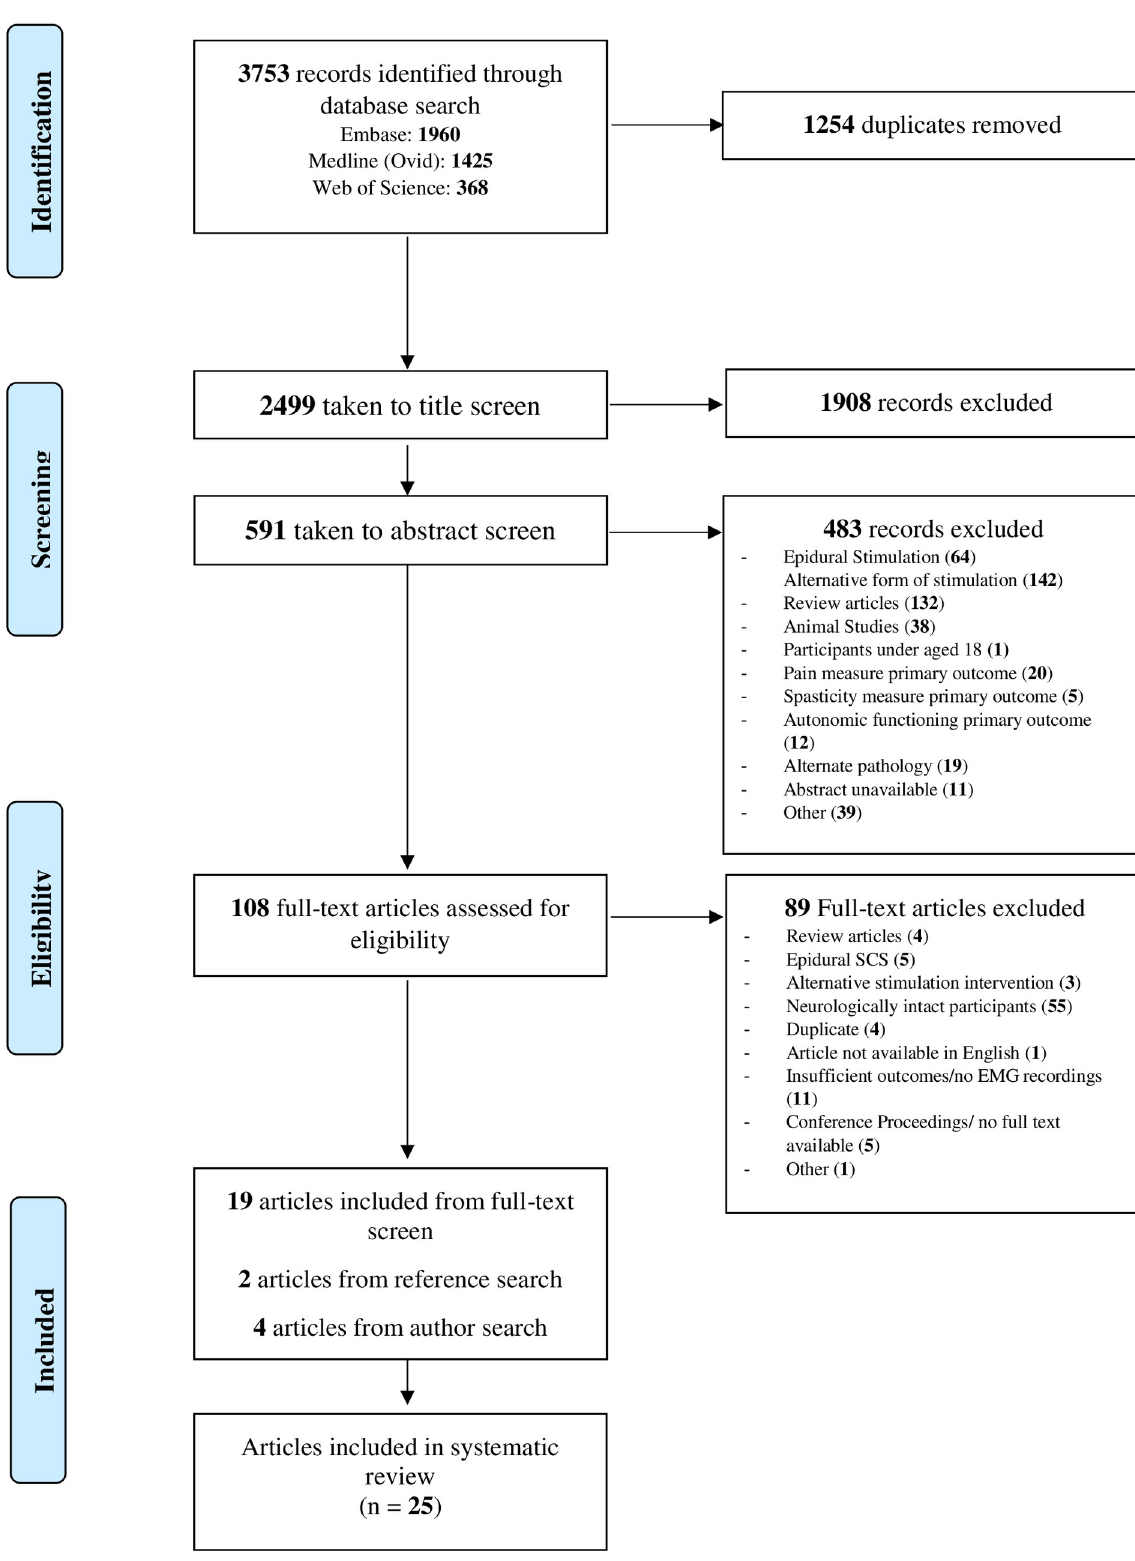
Fig 2. PRISMA flow diagram of screening and selection processes.